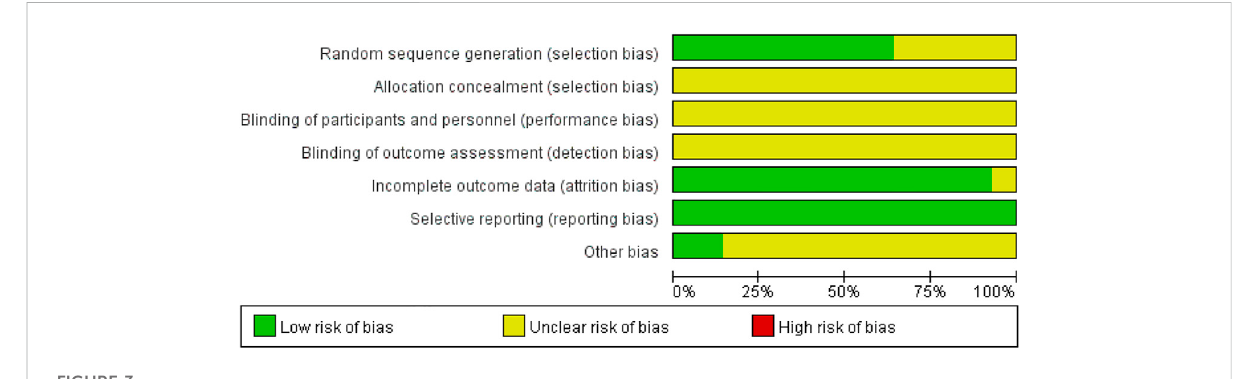
FIGURE 3 Risk-of-bias